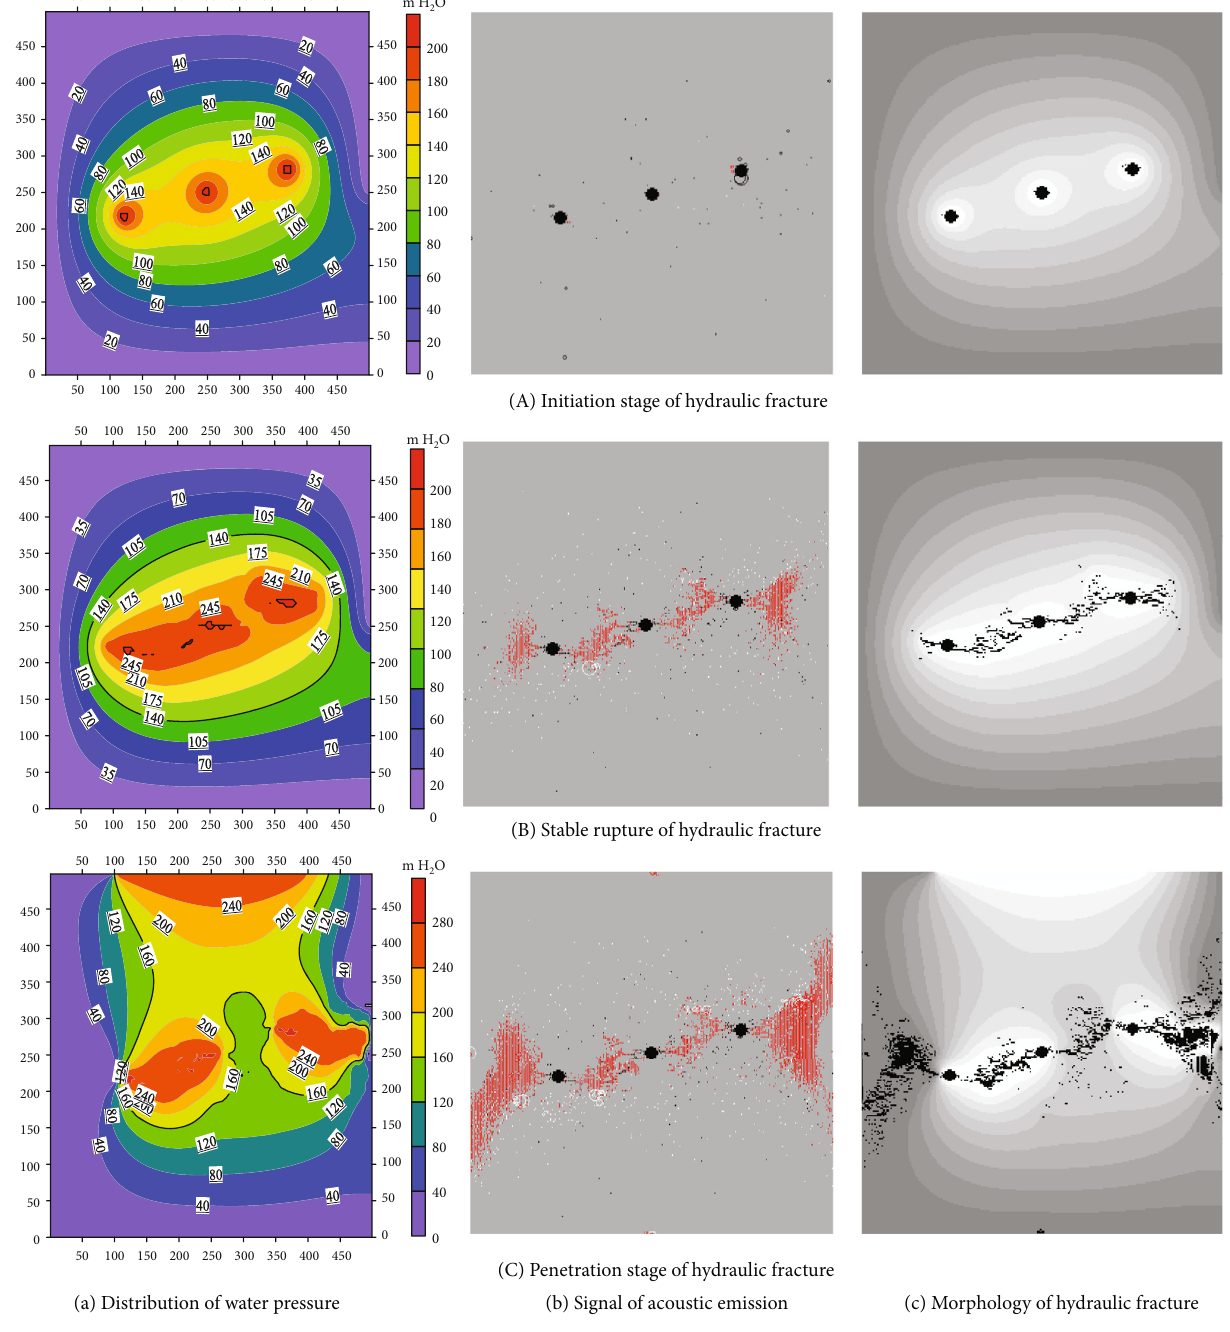
Figure 3: The process of fracture initiation and propagation of multihole linear codirectional hydraulic